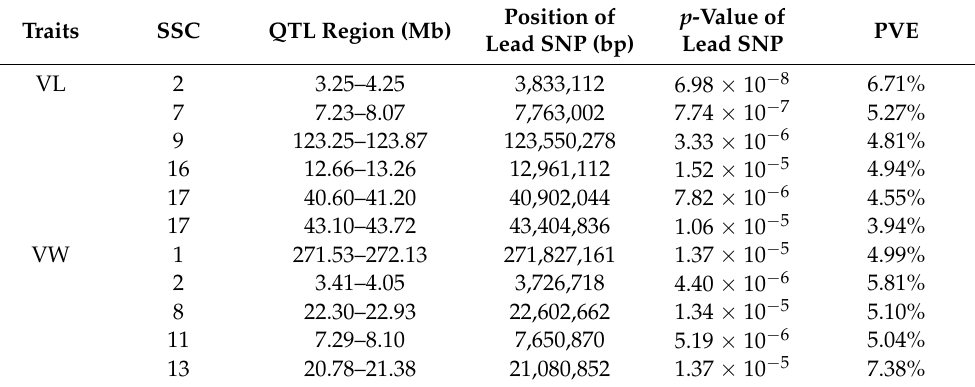
Table 4. Candidate QTLs for three vulvar traits of Suhuai pigs by imputed data.